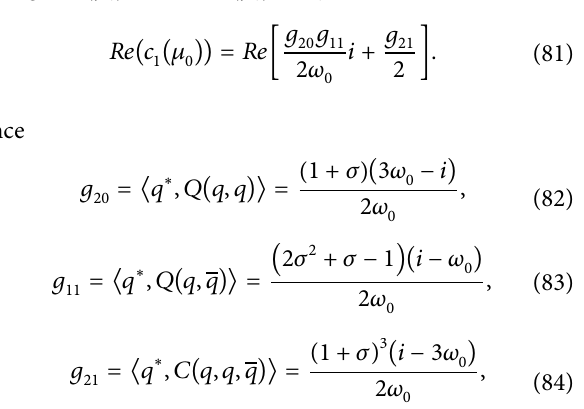
Figure 4: (a) The stable equilibrium and (b) the projection of (a) in